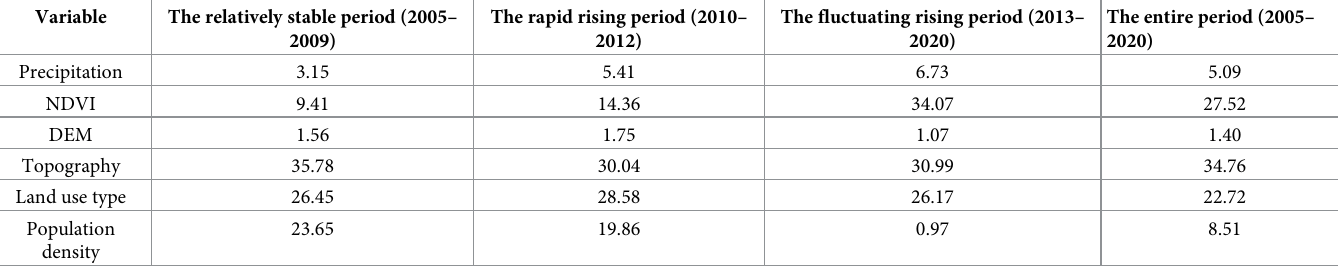
Table 3. Contribution rate (%) of environmental variables to MaxEnt model.